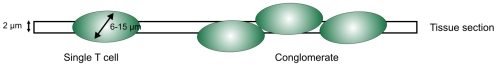
Rationale behind the presented approach.The figure shows the relation of the size of T cells to the height of the used tissue sections (2 µm). The sections are so thin, that there is only minimal overlap between the individual cells of a conglomerate. This allows for calculating the number of cells in a conglomerate by its total area.